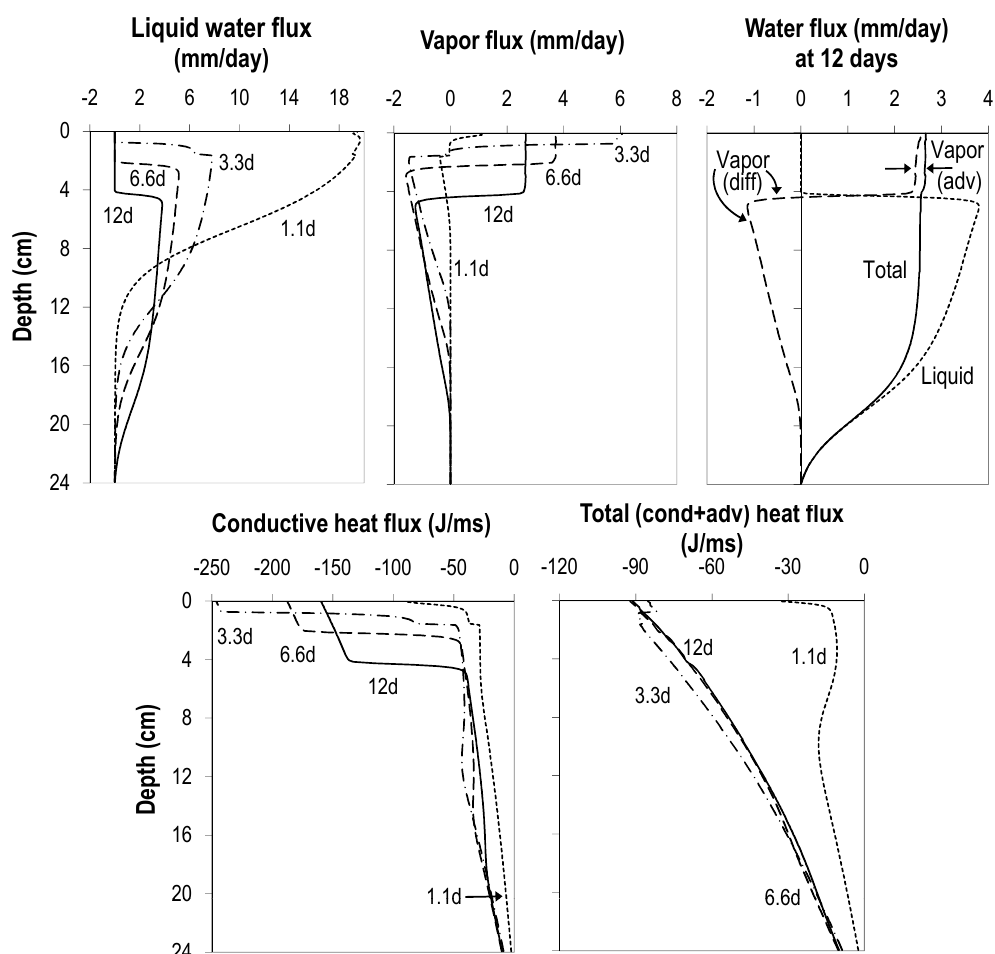
Fig. 4. Computed profiles of liquid, vapor and total water fluxes (above), and conductive and total (conductive plus advective) heat fluxes (below). Positive and negative values stand for upward and downward flows, respectively. The simulation results are shown for four different times (after 1.1 days, 3.3 days, 6.6 days and 12 days). The difference between the diffusive vapor flux and the total water flux, displayed in the top 4cm of the above graph on the right, is equal to the advective vapor